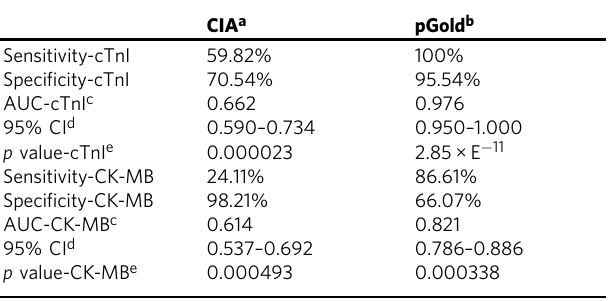
a Sensitivity and speci fi city by CIA were obtained at the cutoffs of 0.04ngmL − 1 for cTnI and 4 ngmL − 1 for CK-MB. b Sensitivity and speci fi city by pGold chip were obtained at the lowered cutoffs of 0.03ngmL − 1 for cTnI and 3.13ngmL − 1 for CK-MB. c AUCs were obtained using the SPSS software (version 19.0, SPSS Inc., Chicago). d CI was calculated based on the Clopper – Pearson method. e p -Value was calculated based on the two-sided Student ’ s t